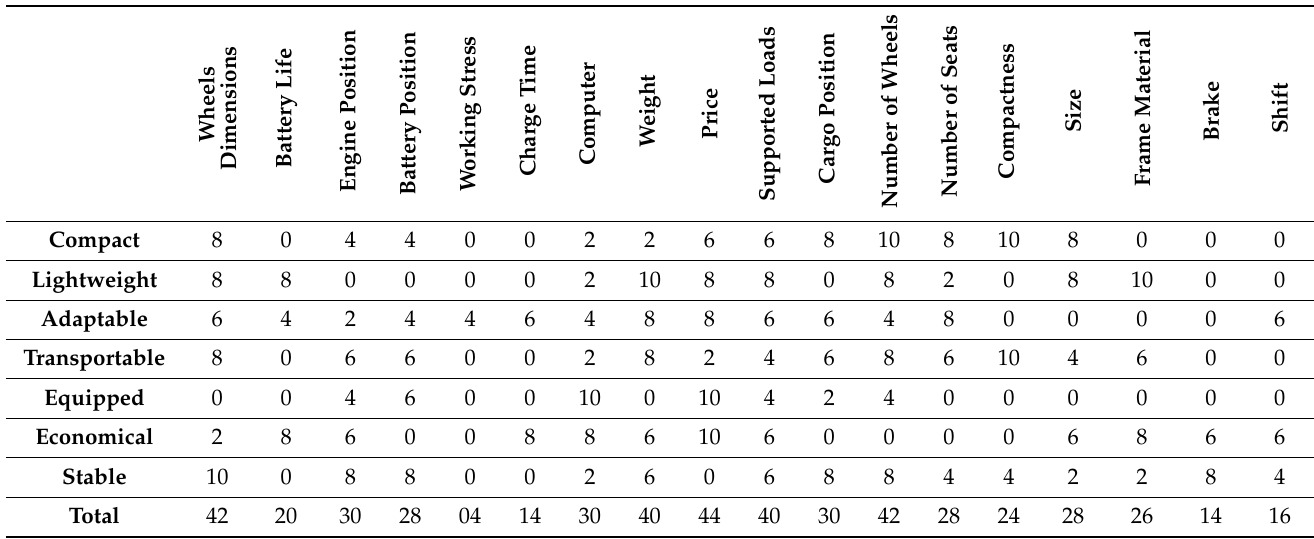
Table 4. What/how